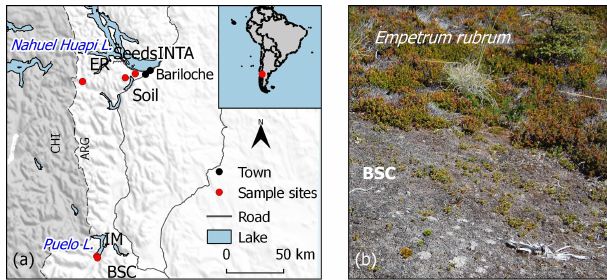
Figure 1. Location of the experimental station (INTA) and sam- pling sites of soil, inert (IM) and plant materials (a) ; mosaic of Em- petrum rubrum and biological soil crust (BSC) in a natural open area within a Nothofagus pumilio forest (b)